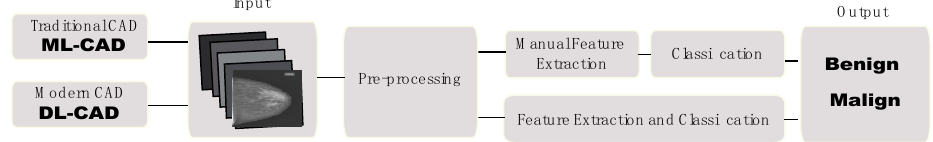
Figure 5. The scheme describes the main difference between the traditional machine learning (ML)-CAD system and the DL-CAD system.